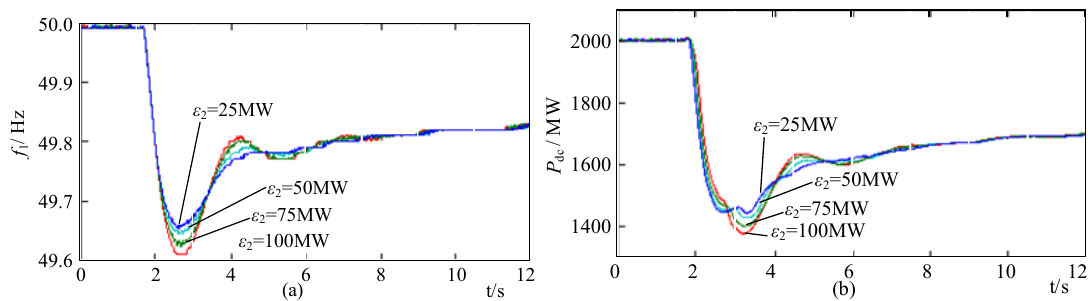
Figure 15. Response characteristics with droop control dead zone changes. ( a ) The frequencies of the sending-end system; ( b ) the actual power transmitted by the UHVDC.